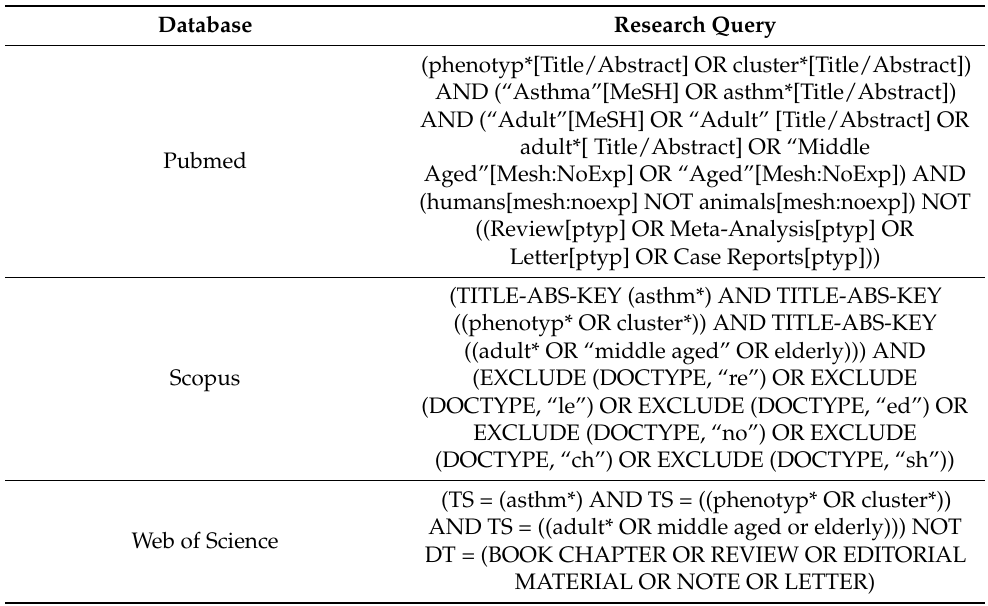
Table 1. List of queries used for searching online